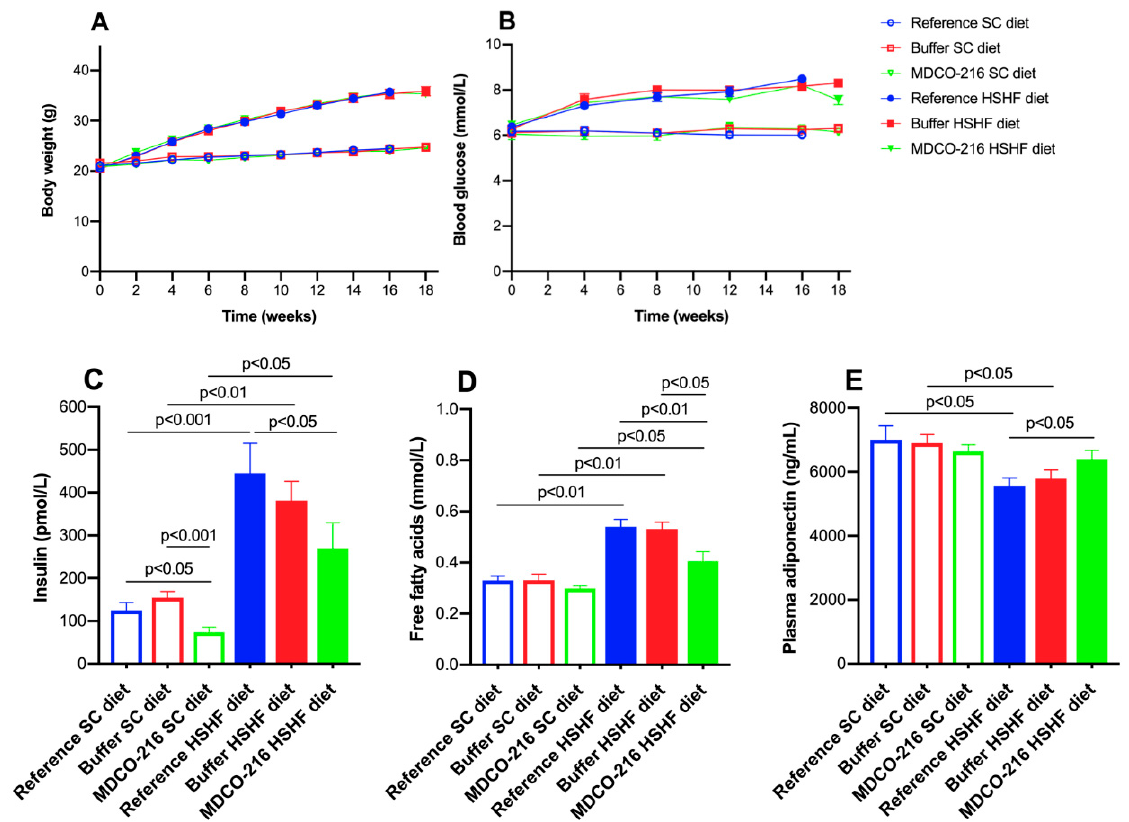
Figure 4. Time course of body weight ( A ) and blood glucose levels ( B ) in reference, buffer, and MDCO-216 C57BL/6N mice fed the SC diet or the HSHF diet. Plasma insulin ( C ), free fatty acids ( D ), and adiponectin ( E ) levels at the time of sacrifice. Week 0 in panels A and B corresponds to the age of 12 weeks, the start of the HSHF diet. All data represent mean ± SEM ( n = 15 for SC diet groups; n = 20 for HSHF diet groups).